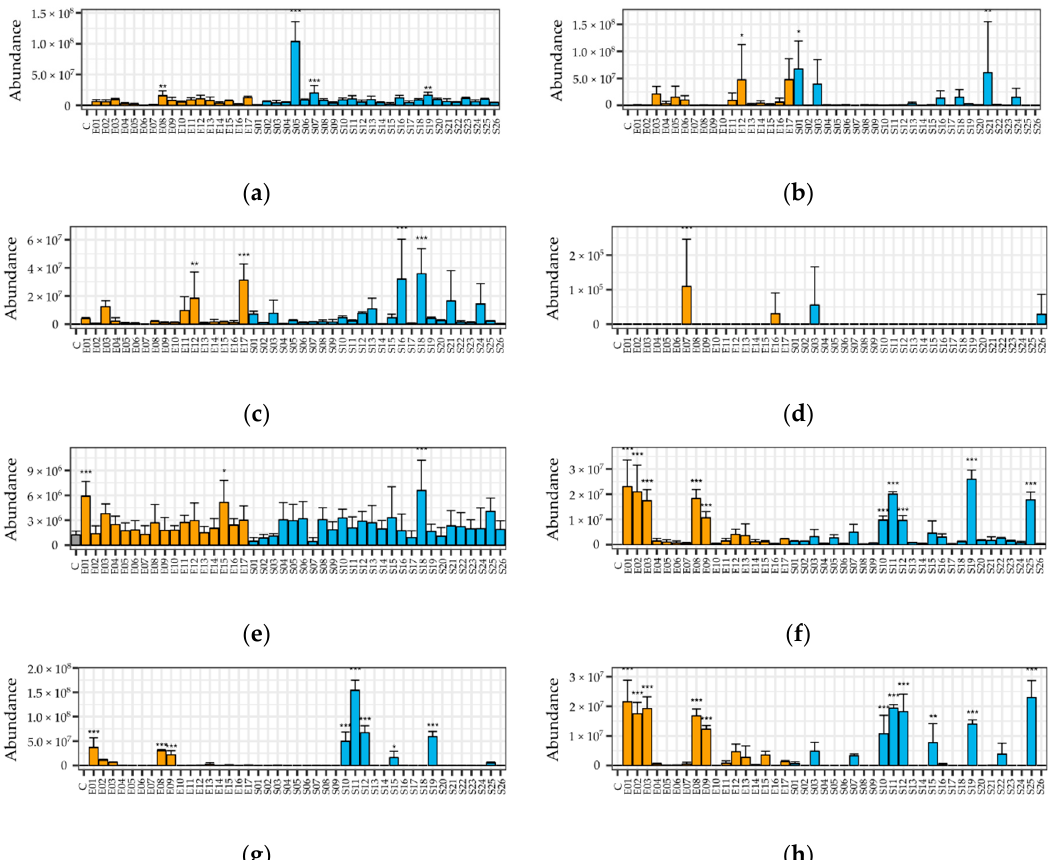
Figure 2. Abundance of selected VOC compounds in the headspace of horseradish extract medium, fermented by endophytic and soil fungi. Presented data are average ± sd of 4 replicates, day 3 and 4 of 2 biological replicates per treatment. The x axis shows the id of the fungus; respective species names can be found in Table 1. Color coding refers to the fungal isolate type: grey—control; orange— endophytic fungus from horseradish roots; blue—soil fungi. Subplots: ( a ) Allyl cyanide (ACN)*; ( b ) Allyl isothiocyanate (AITC)*; ( c ) Carbon disulfide (CS 2 )*; ( d ) Dimethyl sulfide* (Me 2 S); ( e ) acetone*; ( f ) 3-methyl-butanol isomer; ( g ) Ethyl acetate*; ( h ) Possibly sulfur containing, unidentified compound. Compounds marked with an asterisk were identified by comparison with authentic standards. Bars marked with asterisks denote statistically significant differences vs. control (ANOVA, followed by Dunnett post hoc test): *, p < 0.05; **, p < 0.01; ***, p < 0.001.